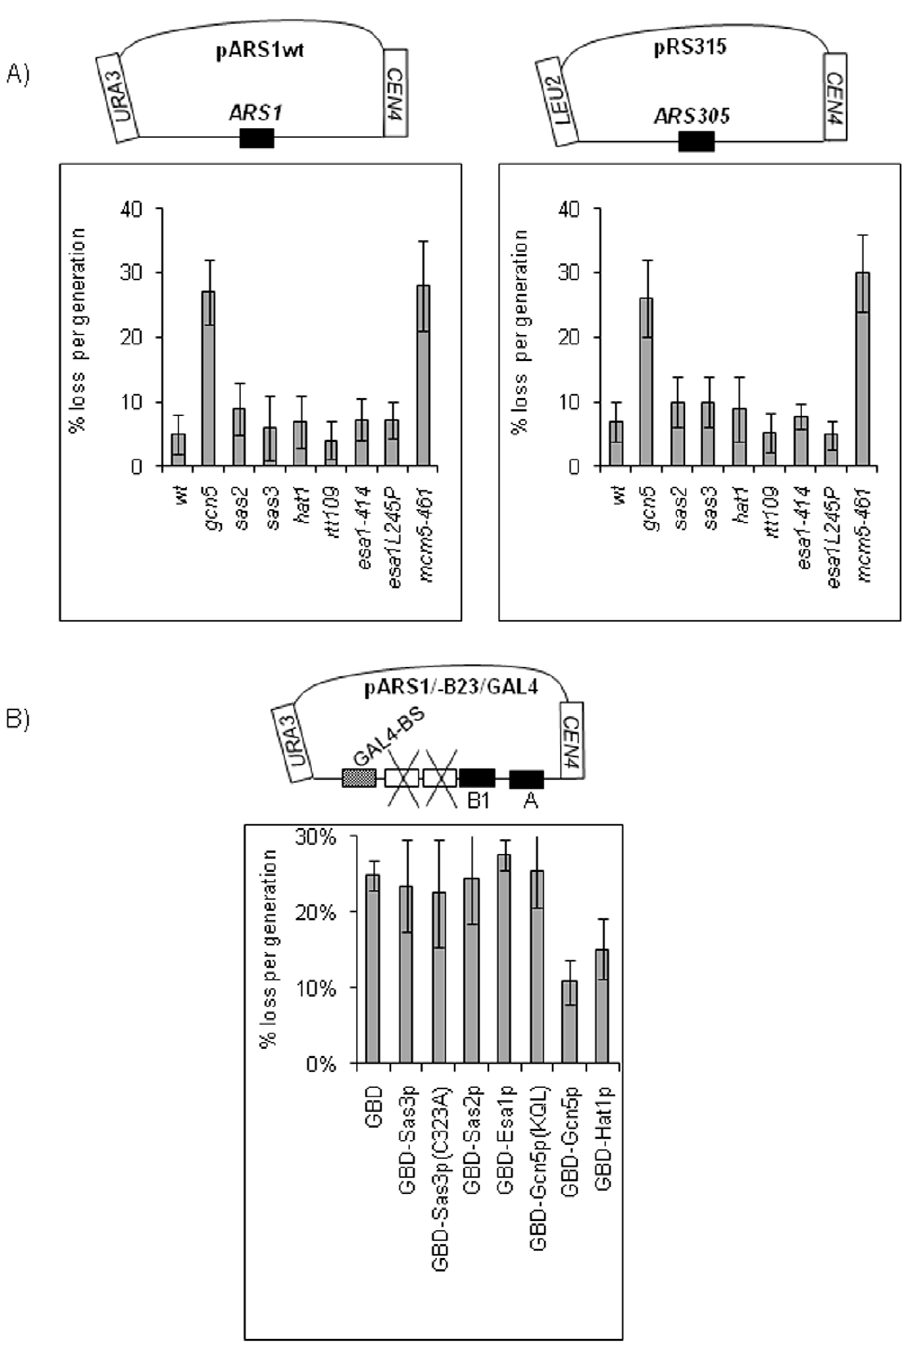
Figure 1. GCN5 regulates mini-chromosome stability. A. Disruption of GCN5 increases the loss rate of ARS1- or ARS305- mini- chromosomes. Maps of pARS1wt ( ARS1, CEN4, URA3 ) and pRS315 (ARS305 , CEN4 , LEU2 ) mini-chromosomes are shown on the top of the graphs. The mini-chromosomes were transformed in the strains shown at the bottom of the graphs. After growth on selective plates (SC-ura or SC-leu, respectively) three colonies were transferred for 20 generations in rich medium (YPD) and plated on YPD and SC-ura or SC-leu, respectively. The proportions of cells with URA + or LEU + phenotypes were assessed and the average loss rate per generation was calculated (%) and plotted. Error bars represent standard deviations between the three parallel counts in the experiment. A typical outcome of one of three independent experiments is shown. B. Tethering of Gcn5p increases the stability of pARS1/-B23/GAL4. A diagram of pARS1/-B23/GAL4 (ARS1-B2-B3 + GAL4, CEN4, URA3) is shown on the top. The B2 and B3 elements of ARS1 are destroyed and a GAL4 binding site (GAL4-BS) is inserted next to B3. DF5gal4 D cells were co- transformed with pARS1/-B23/GAL4 and episomes ( 2 m m/HIS3 ) expressing the GAL4 DNA binding domain fused to the proteins indicated below the graph. Gcn5p(KQL) lacks HAT activity. Average pARS1/-B23/GAL4 loss per generation and standard deviation were calculated as in Figure 1a. A typical outcome of one of two independent experiments is shown.